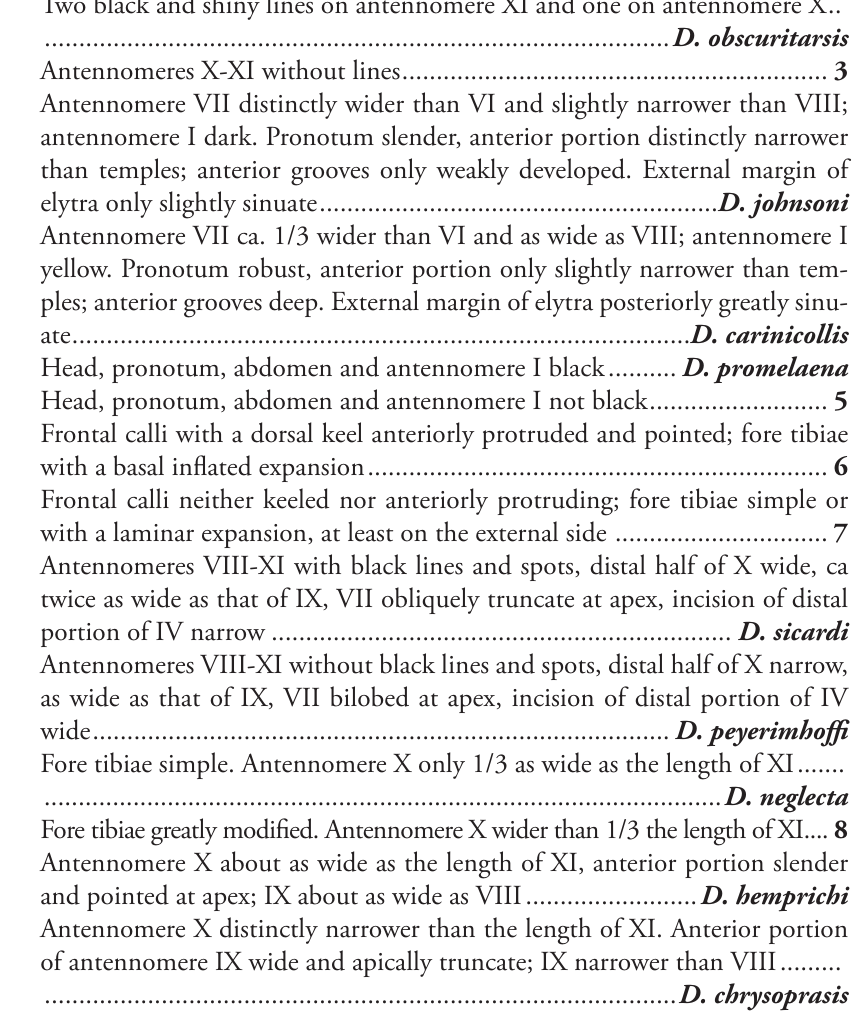
Two black and shiny lines on antennomere XI and one on antennomere X .. – Antennomeres X-XI without lines .............................................................. 3 3 Antennomere VII distinctly wider than VI and slightly narrower than VIII; antennomere I dark. Pronotum slender, anterior portion distinctly narrower than temples; anterior grooves only weakly developed. External margin of – Antennomere VII ca. 1/3 wider than VI and as wide as VIII; antennomere I yellow. Pronotum robust, anterior portion only slightly narrower than tem- ples; anterior grooves deep. External margin of elytra posteriorly greatly sinu-